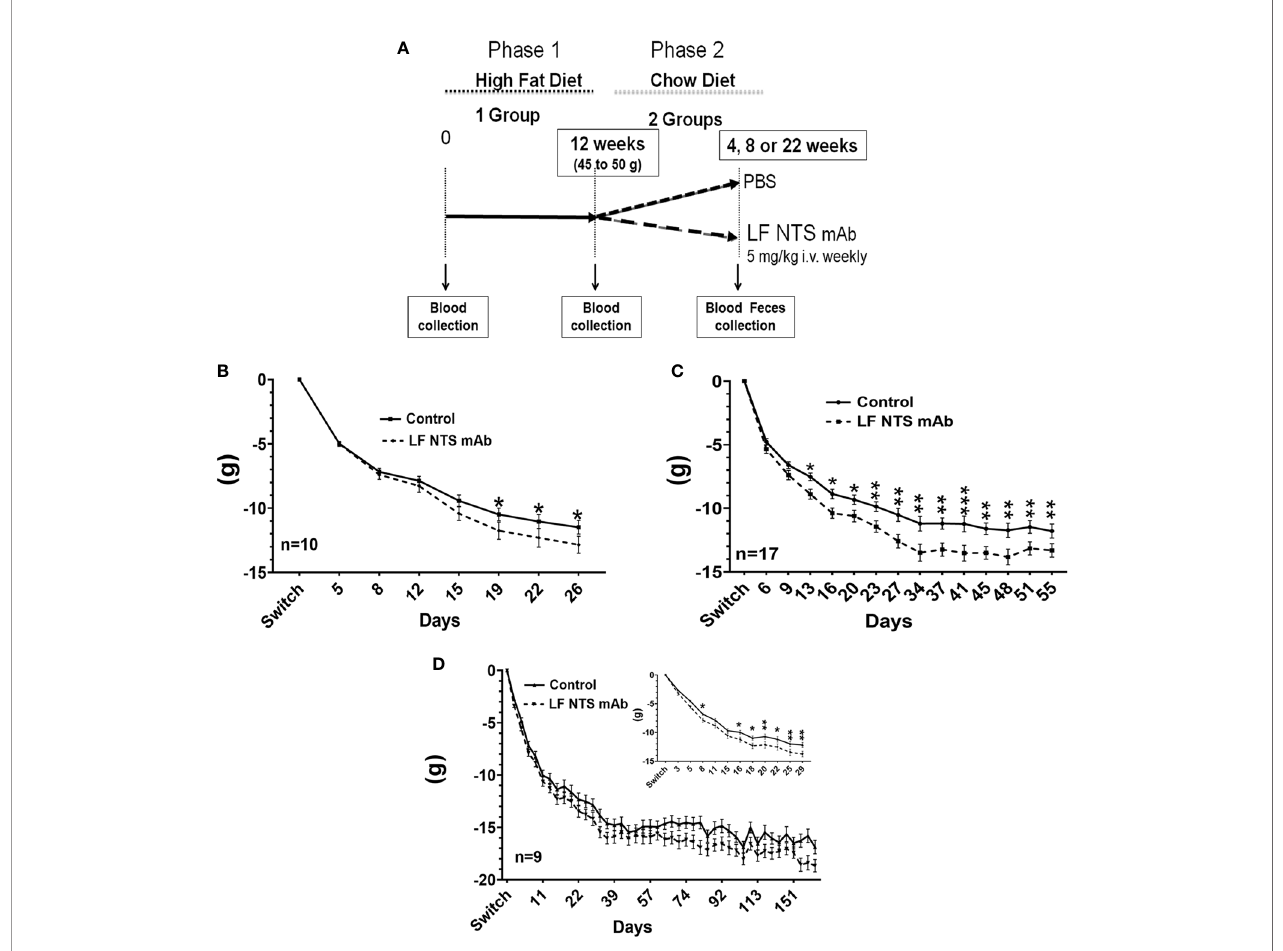
FIGURE 1 | Weight lost by mice after the diet switch from high fat to chow diets. (A) Follow-up of the weight lost was performed on obese mice after the switch from HFD to chow and treated with FL-NTS mAb. Four independent experiments were performed. The weight lost was studied over different periods. (B) The fi rst period while mice were losing weight was named a short period (SP) (n=10), (C) The second period corresponding to the weight stabilization was named long period (LP) (n=17) representing the mean of three independent experiments. (D) The LF NTS mAb was prolonged for 9 mice and maned long term (LT), (D inset).Magni fi cation of the weight follow up during the fi rst 29 days. Two-way ANOVA *p < 0.05; **p < 0.01; ***p <